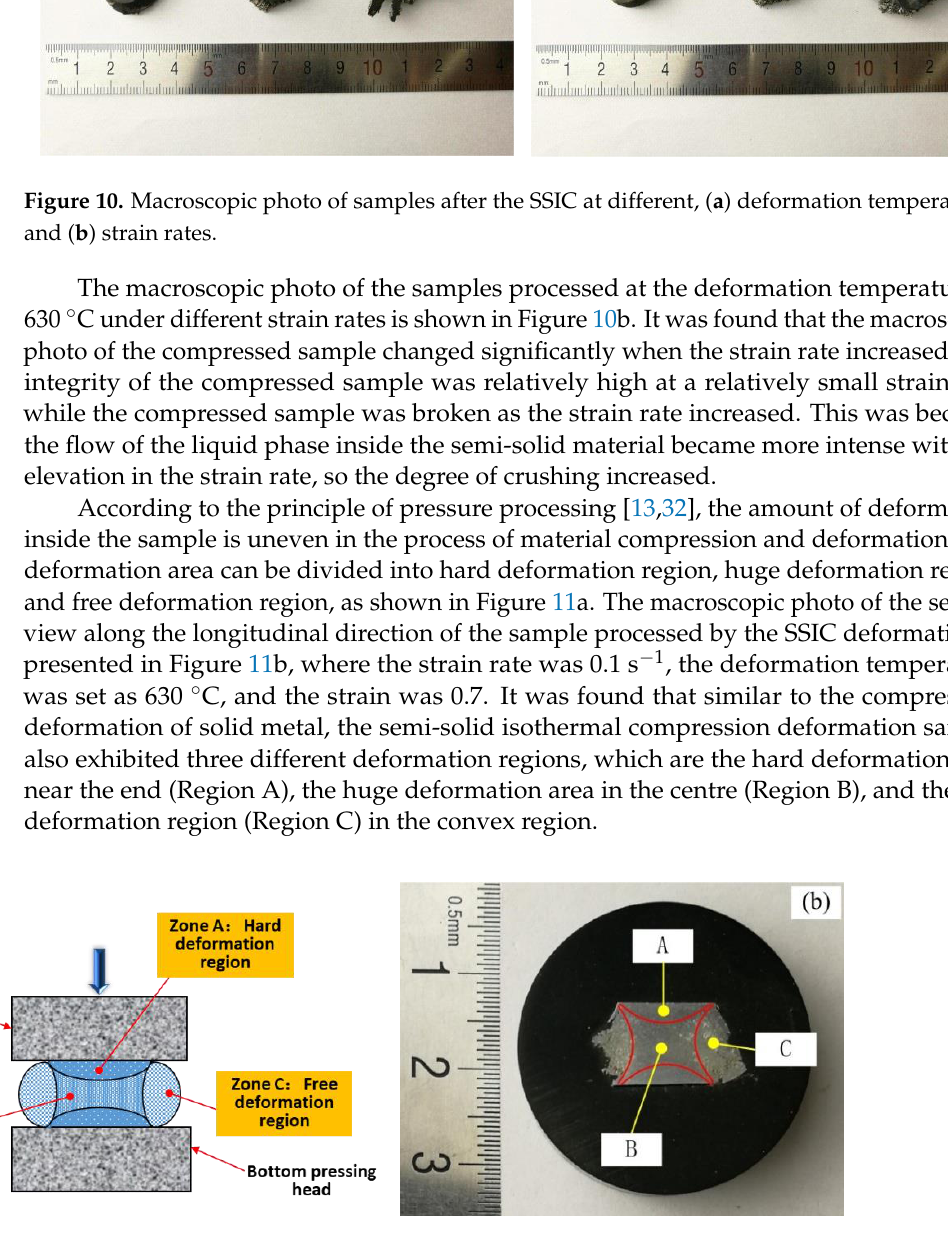
Figure 11. Deformation characteristics of the compressed samples: ( a ) Deformation region division, and ( b ) the longitudinal macroscopic photo of samples after the semi-solid isothermal compression (deformation temperature: 630 °C, strain rate: 0.1 s −1 ).